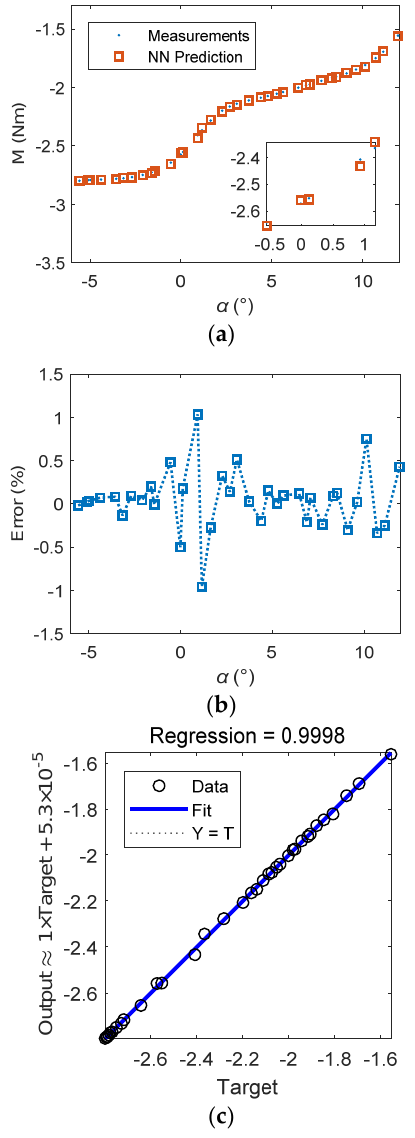
Figure 5. The BP NN test results: ( a ) comparison of measurements and NN prediction; ( b ) the prediction error; ( c ) regression of test samples.